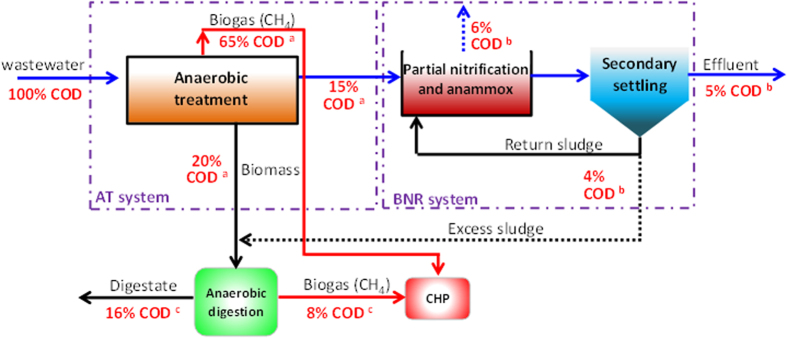
COD mass flow in A-B process with anaerobic treatment as A-stage and partial nitrification and anammox as B-stage; (a) data from Gopala Krishna et al.37; (b) data from Metcalf and Eddy12; (c) data from Parkin and Owen47.